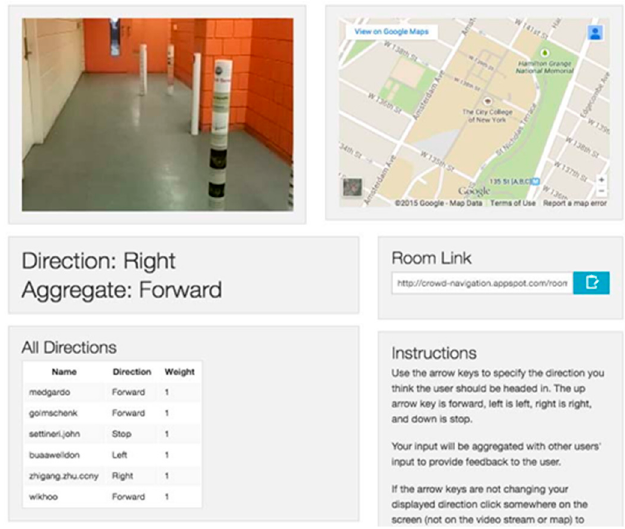
Figure 30. The implemented app [53].